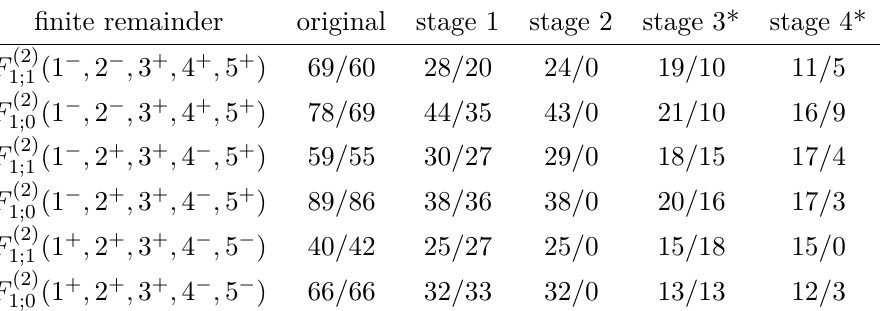
Table 1 . Maximal numerator/denominator polynomial degrees of the rational coefficients of the most complicated finite remainders at each stage of our reconstruction strategy. The column “orig- inal” refers to the rational coefficients prior to any optimisation. The asterisk * highlights that, after the partial fraction decomposition in stage 3, the coefficients to be reconstructed depend on one fewer